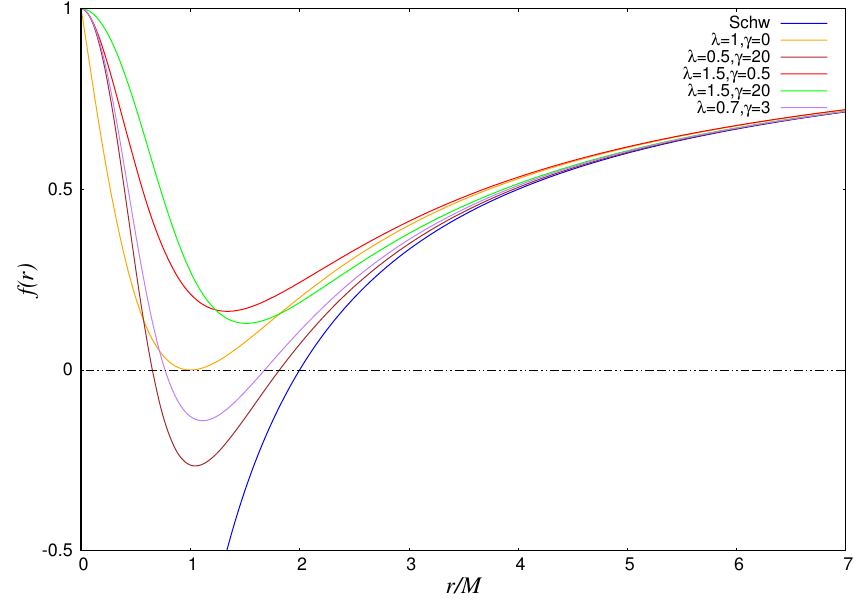
Figure 1. f ( r ) as a function of r / M